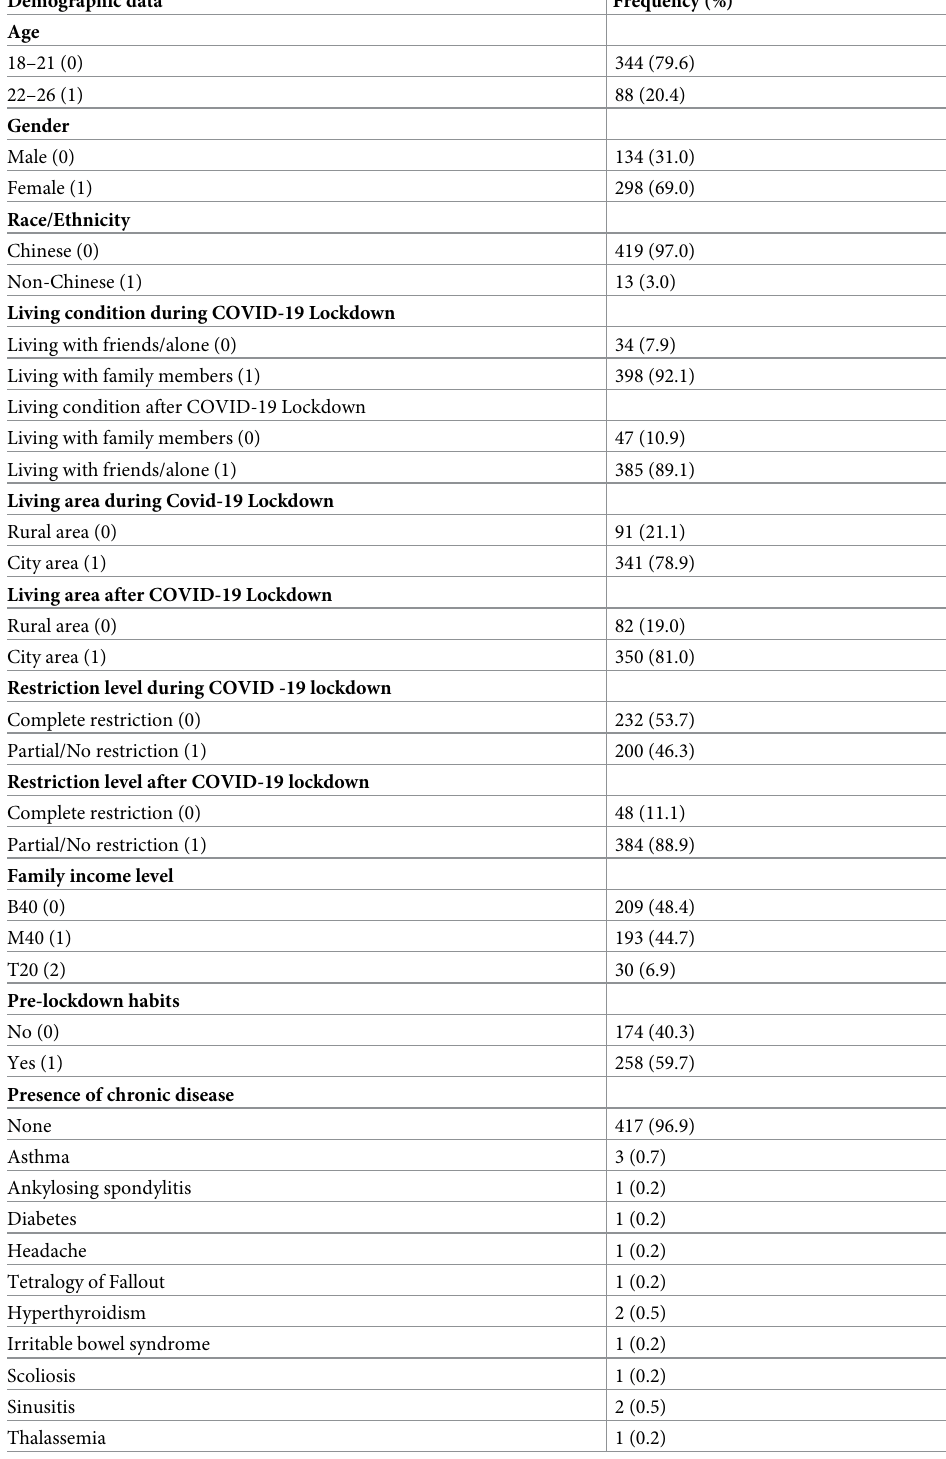
Table 1. Participant